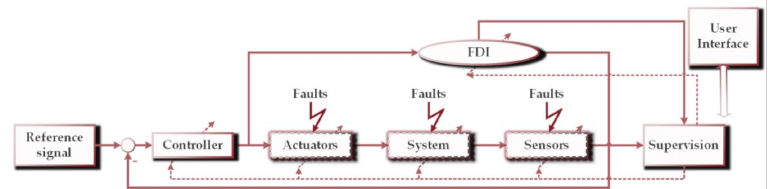
Figure 1. General diagram of a fault tolerant control